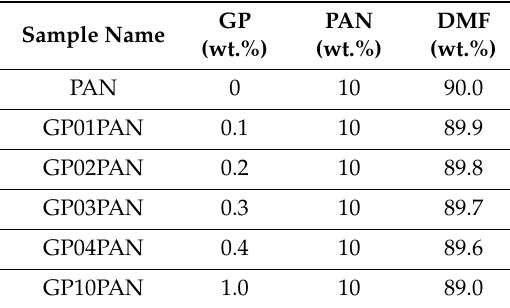
Component ratio of polyacrylonitrile (PAN) and graphene oxide modified by polydiallyldimethylammonium chloride / polyacrylonitrile (GP / PAN) electrospinning solution. (DMF = N,N-dimethyl formamide). Sample